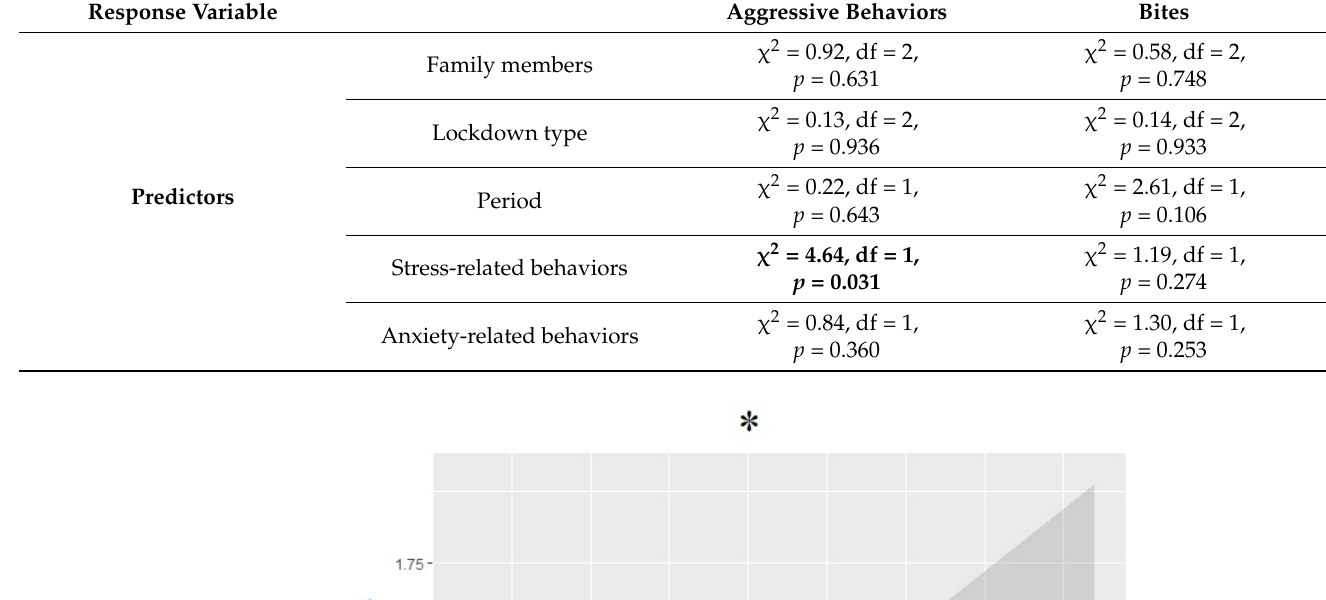
Table 4. Statistical outputs from ordinal logistic regressions for dogs.